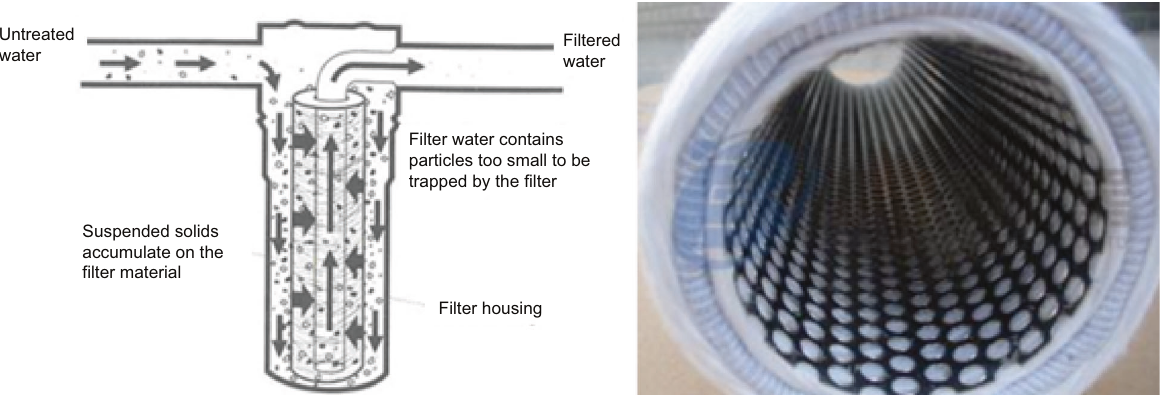
Fig. 5 Schematic of string-wound sediment cartridge fi lter. Suspended solids from untreated water will accumulate throughout the depth of the fi lter material, while dissolved contaminants are not retained. Therefore, the classi fi cation and removal ef fi cacy of sediment fi lters is highly dependent on the pore size of the fi lter media (reprinted with permissions from 54,57 ; Copyright © Filters Fast LLC, 2020; Copyright © UNISUN,